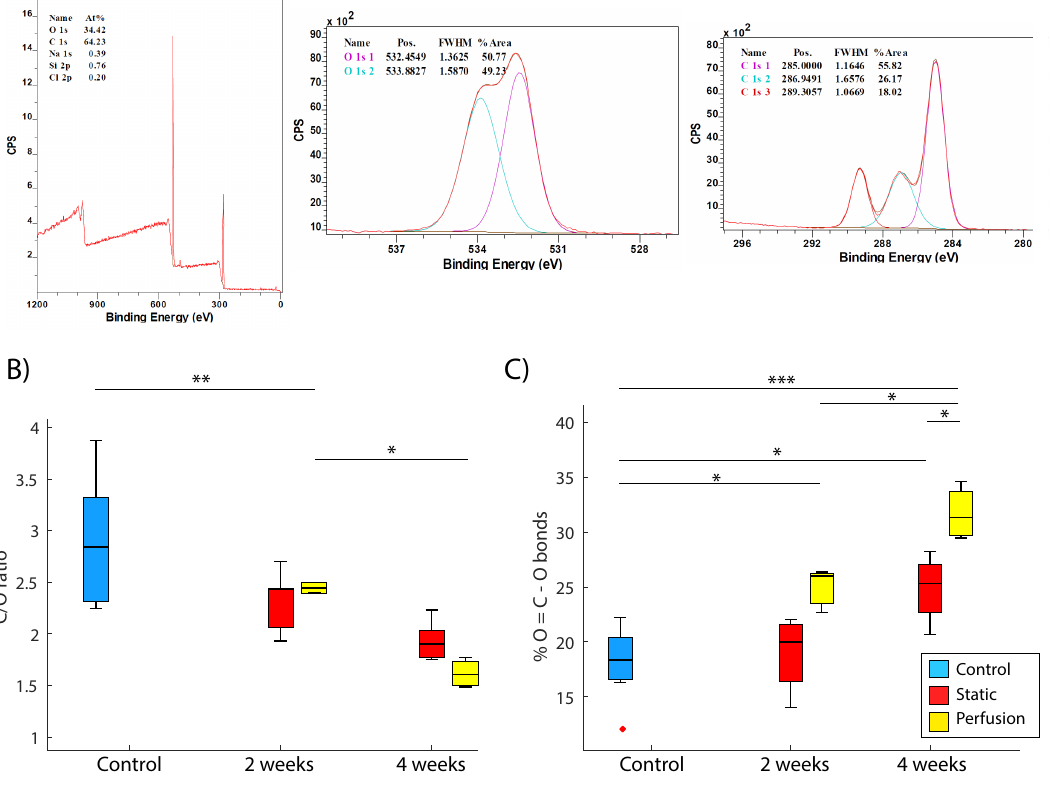
Figure 7. ( A ) XPS report: general spectrum of an analyzed zone (300 µ m) where the main signals are obtained for carbon and oxygen (left) and high resolution spectrum for specific regions of C and O (1 s) (right). ( B ) C/O ratio on the sample surface. ( C ) % of O-C=O bonds in the samples. Readings were obtained in the first 10 nm of the surface. For both B and C plots: Control data (blue) was obtained from non-incubated scaffolds. Static (red) and perfusion (yellow) were assayed after drying the sample at the end of the experiment. Statistical significance was considered for a p -value < 0.05 (* p < 0.5, ** p < 0.005, *** p < 0.001), x outlier